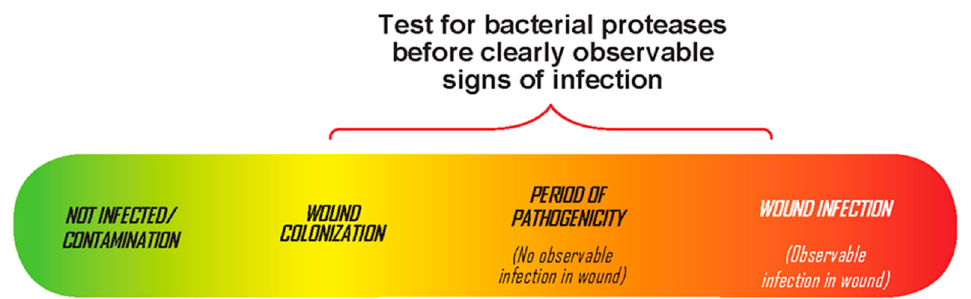
Figure 1. The continuum of bacteria in chronic wounds. Testing for pathogenic bacteria prior to observable signs of infection.